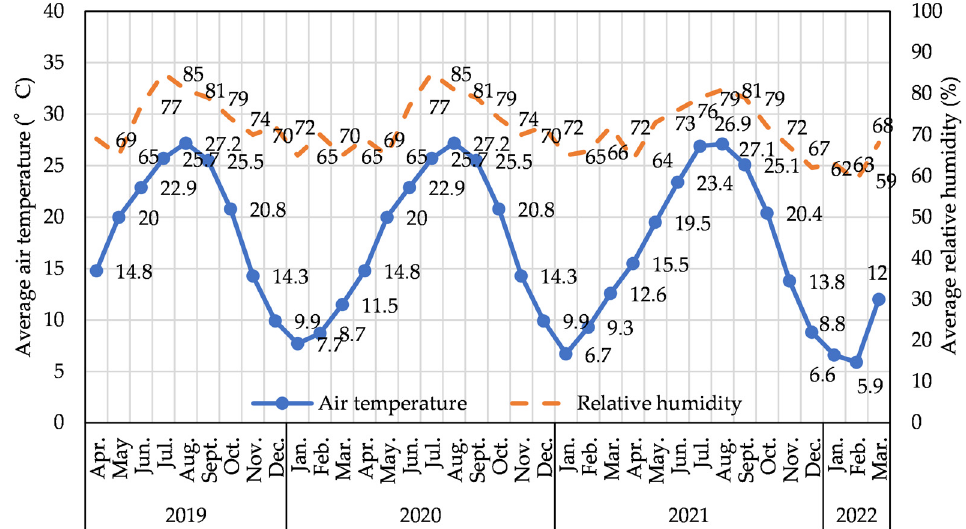
Figure 4. Oita City April 2019–March 2022 monthly air temperature and relative humidity.